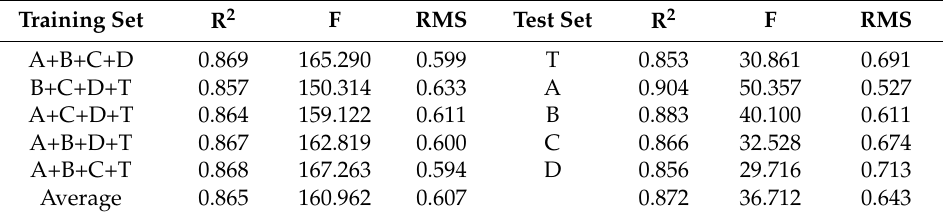
Table 7. Validation of the MLR